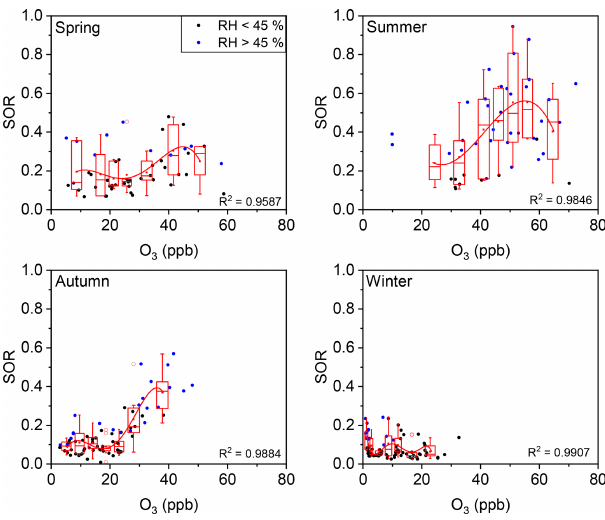
Figure 7. Plot of the SOR against O 3 grouped by RH. The solid blue circles represent RH > 45% and the solid black circles repre- sent RH < 45%. The boxes represent, from top to bottom, the 75th, 50th, and 25th percentiles in each bin. The bin widths were set such that there was an approximately equal number of data points in each bin. The whiskers, solid red squares, and open red circles represent 1.5 times the IQR, mean values, and outlier data points, respectively. The red lines are best fits to mean values based on polynomial func- tions. Data for days with rain or snow were excluded from these plots.